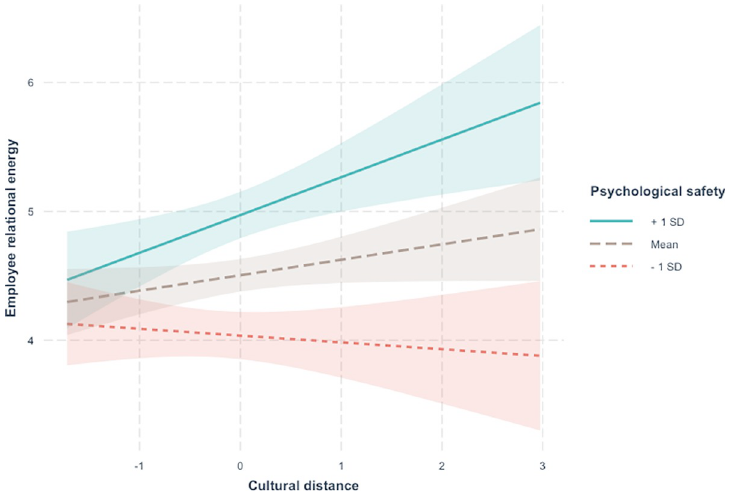
Fig 2. Interaction between cultural distance and psychological safety in Study